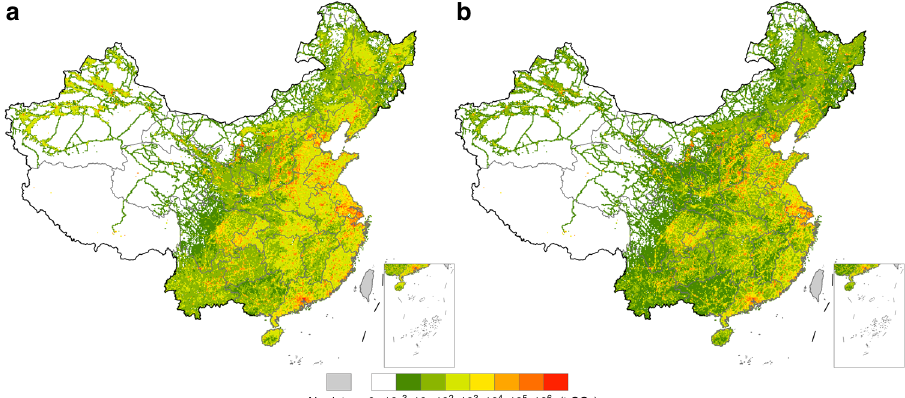
Fig. 5 Carbon footprint hotspot maps driven by exports for two different categories of fi nal demand. a shows the carbon footprint hotspots driven by exports for household consumption, and b shows the carbon footprint hotspots driven by exports for gross fi xed